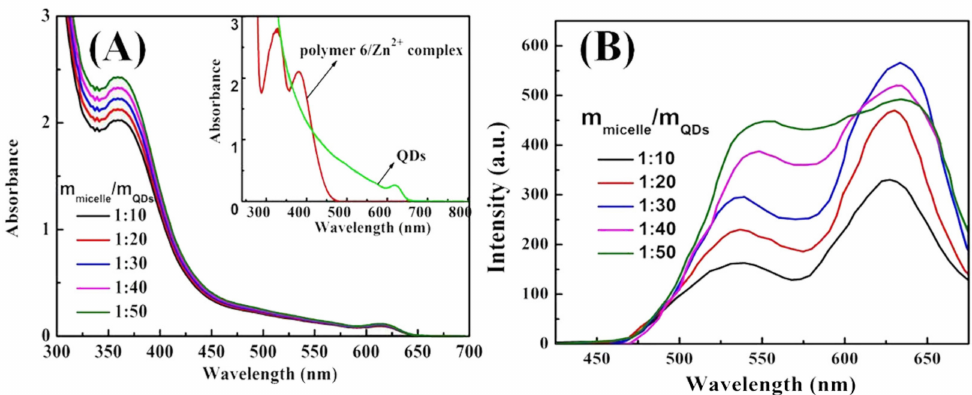
Figure 6. ( A) UV–Vis absorption spectra and ( B ) PL spectra of M6@CdTe / ZnS with di ff erent M6-3 / QDs ratio from 1:10 to